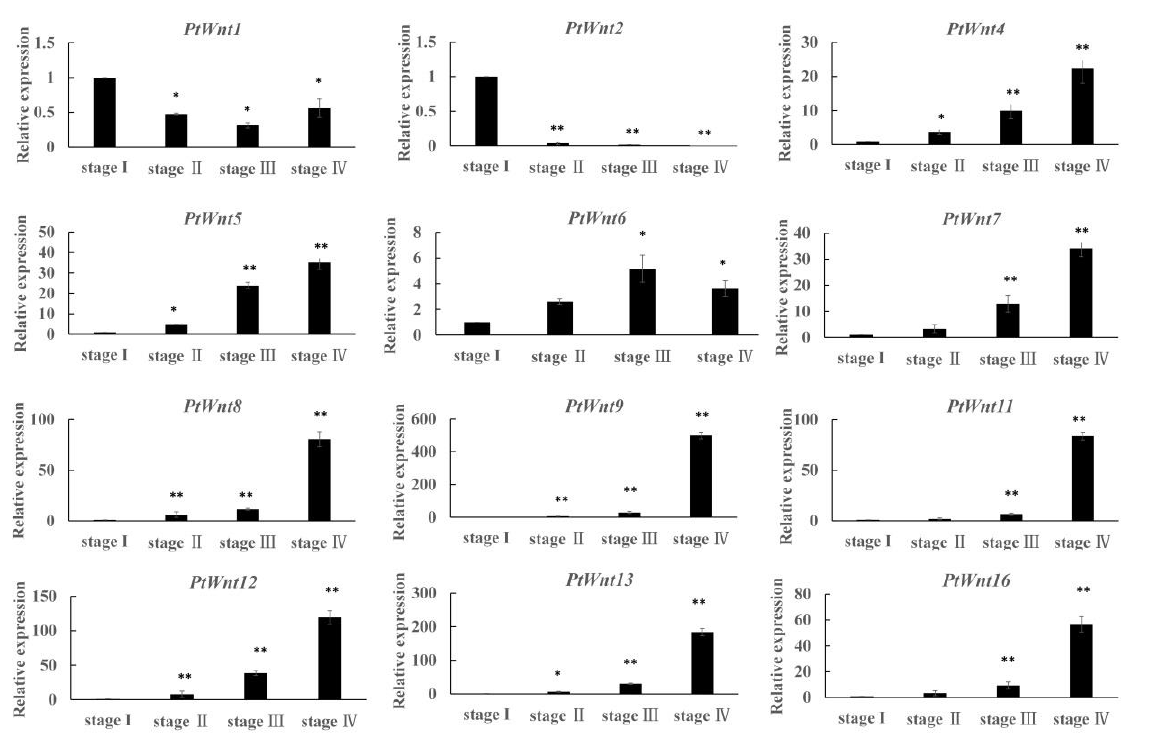
Figure 8. Expression patterns of 12 PtWnts at four developmental stages of the regenerating limb. The expression of target genes was detected by qRT-PCR and normalized to β - actin gene as the internal reference. The results were based on three independent biological replications and show mean values ± SD. ( * p ＜ 0.05, ** p ＜ 0.01).